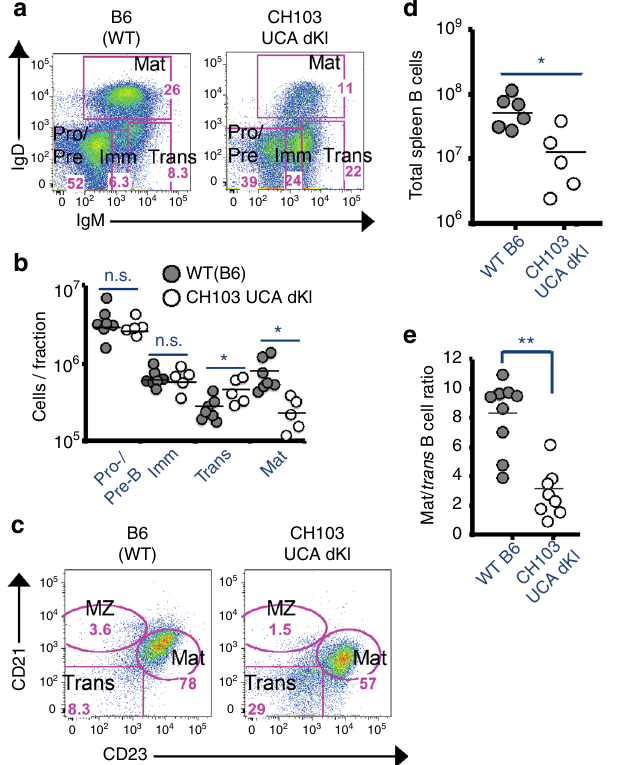
Fig. 4 Immune tolerance in CH103 germ line knock-in mice. a – c Bone Marrow B cell development in naive CH103 unmutated common ancestor (UCA) double knock-in (dKI) mice, compared to wild type (B6), showing anergic phenotype and reduced frequencies of mature B cells associated with the second tolerance checkpoint. a Flow histograms indicating percentages in progenitor/precursor (Pro/pre), Immature (Imm), Transitional (Trans), and Mature (Mat) subsets. Data gated on live, total (CD19 + B220 + ) B cells. b Graphical summary of data shown in ( a ) for several mice. c – e Peripheral B cell development in naive CH103 UCA dKI mice, showing reduced total B cell numbers and frequencies of follicular mature B cells. c Representative fl ow histograms indicating percentages of total, live gated splenic B cells in transitional (Trans), marginal zone (MZ), and mature follicular (Mat) subsets. Graphical representation of total splenic B cell numbers ( d ) or mature to transitional ratios ( e ), as a measure of developmental arrest (transitional B cell accumulation) in periphery. Circles represent individual mice, and means are denoted by black bars. * P < 0.05; ** P < 0.005, two-tailed Student ’ s t- test. n.s. not signi fi Fig. 9). Relative to control-immunized (saline-injected) mice and